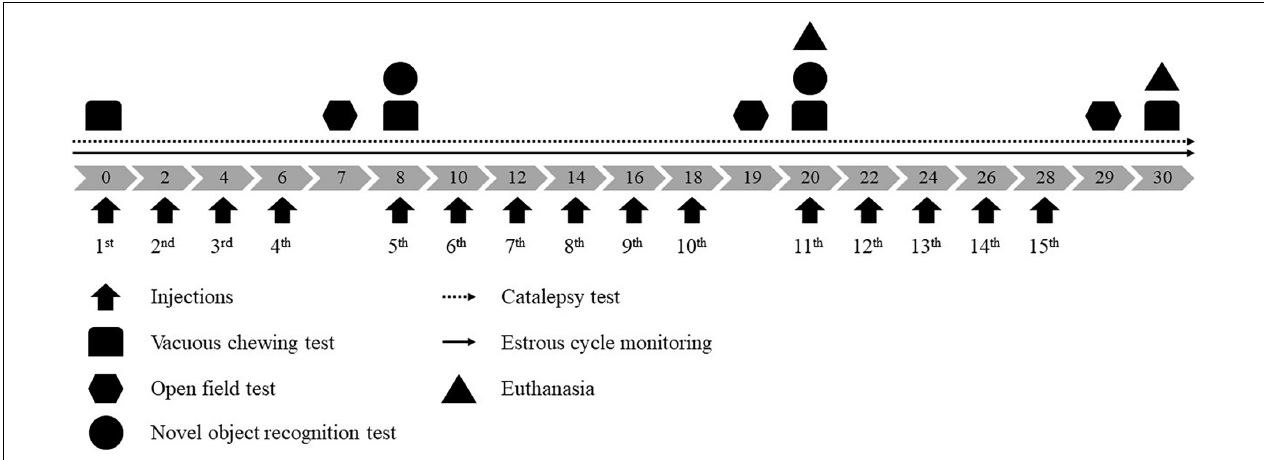
FIGURE 1 | Experimental design. Gray arrows indicate days of treatment and black arrows pointed up indicate vehicle or 0.1 mg/kg reserpine s.c. injections.